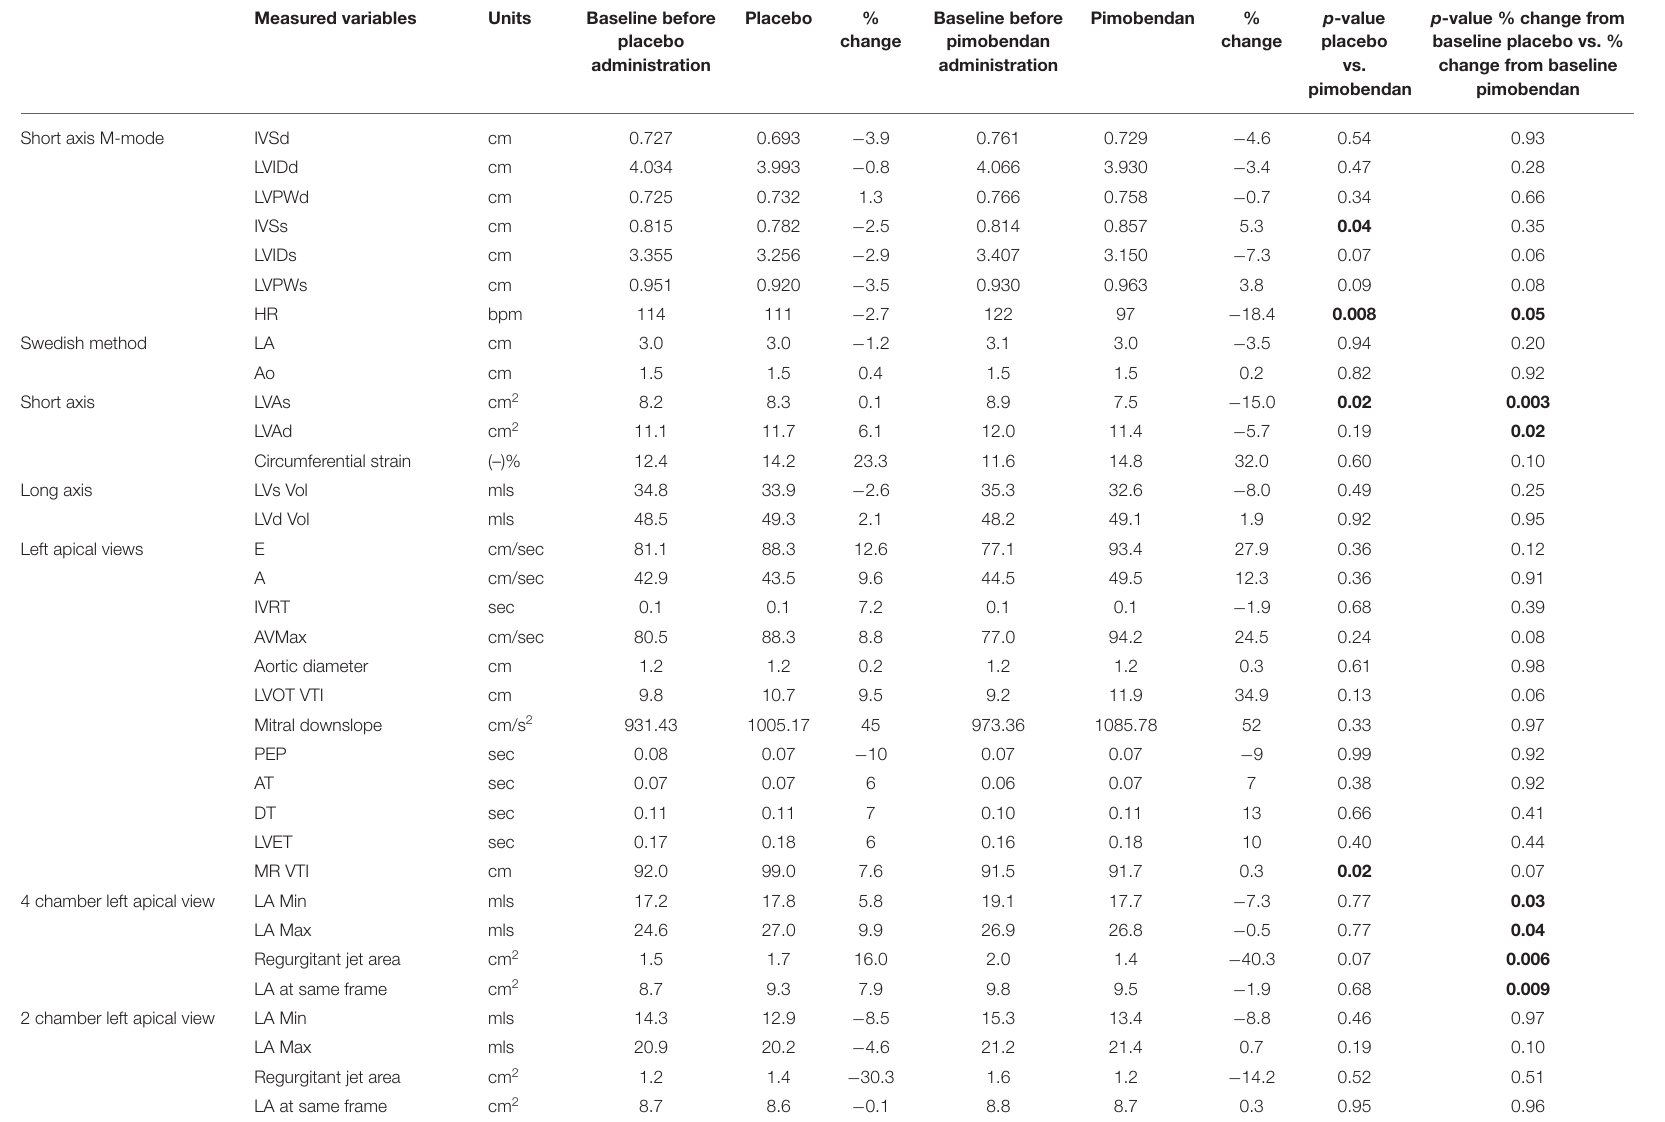
TABLE 1 | Measured echocardiographic variables. Measured variables Units Baseline before